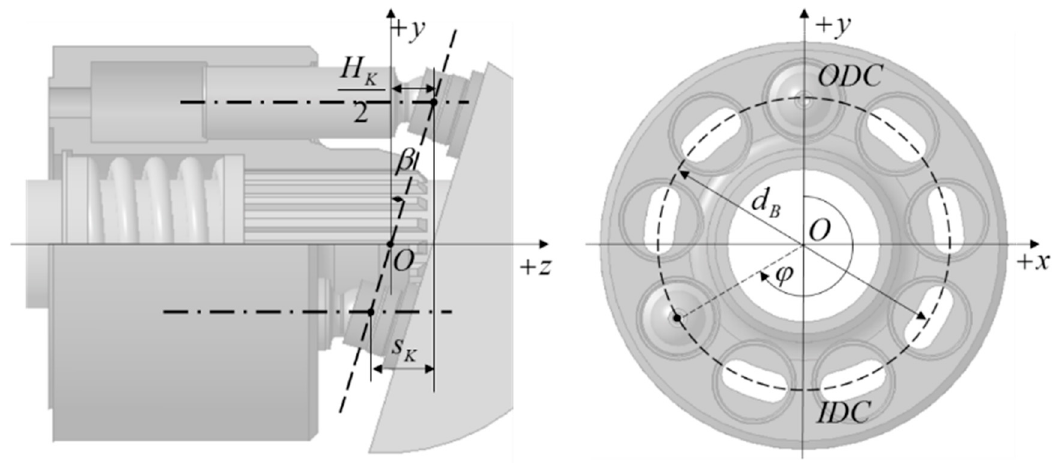
Figure 2. Swashplate-type axial piston machine.